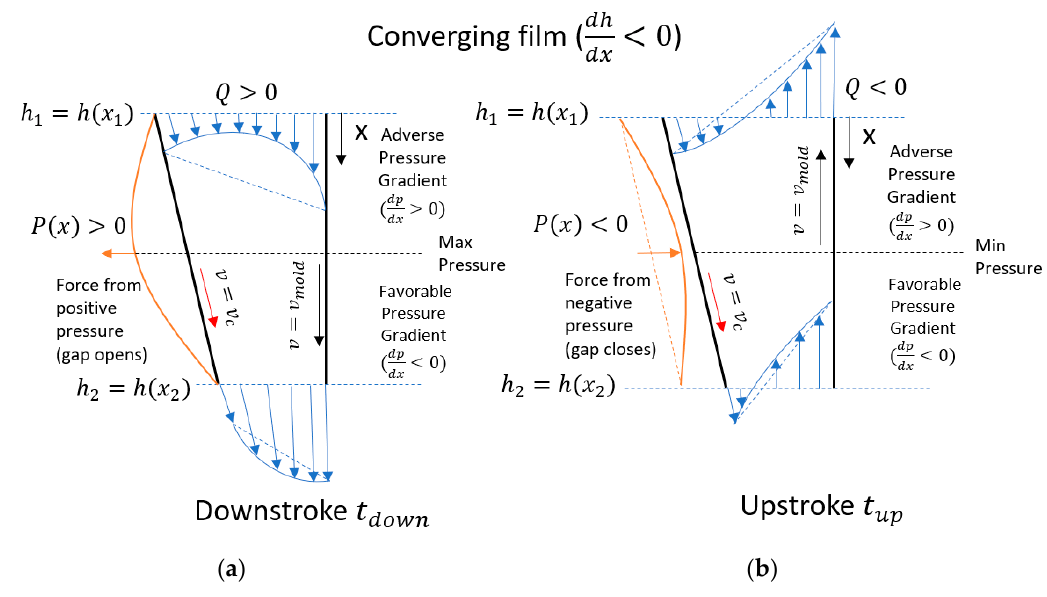
Figure 2. Velocity and pressure profiles in converging slag film during mold oscillation cycle: ( a ) At downstroke, ( b ) at upstroke.